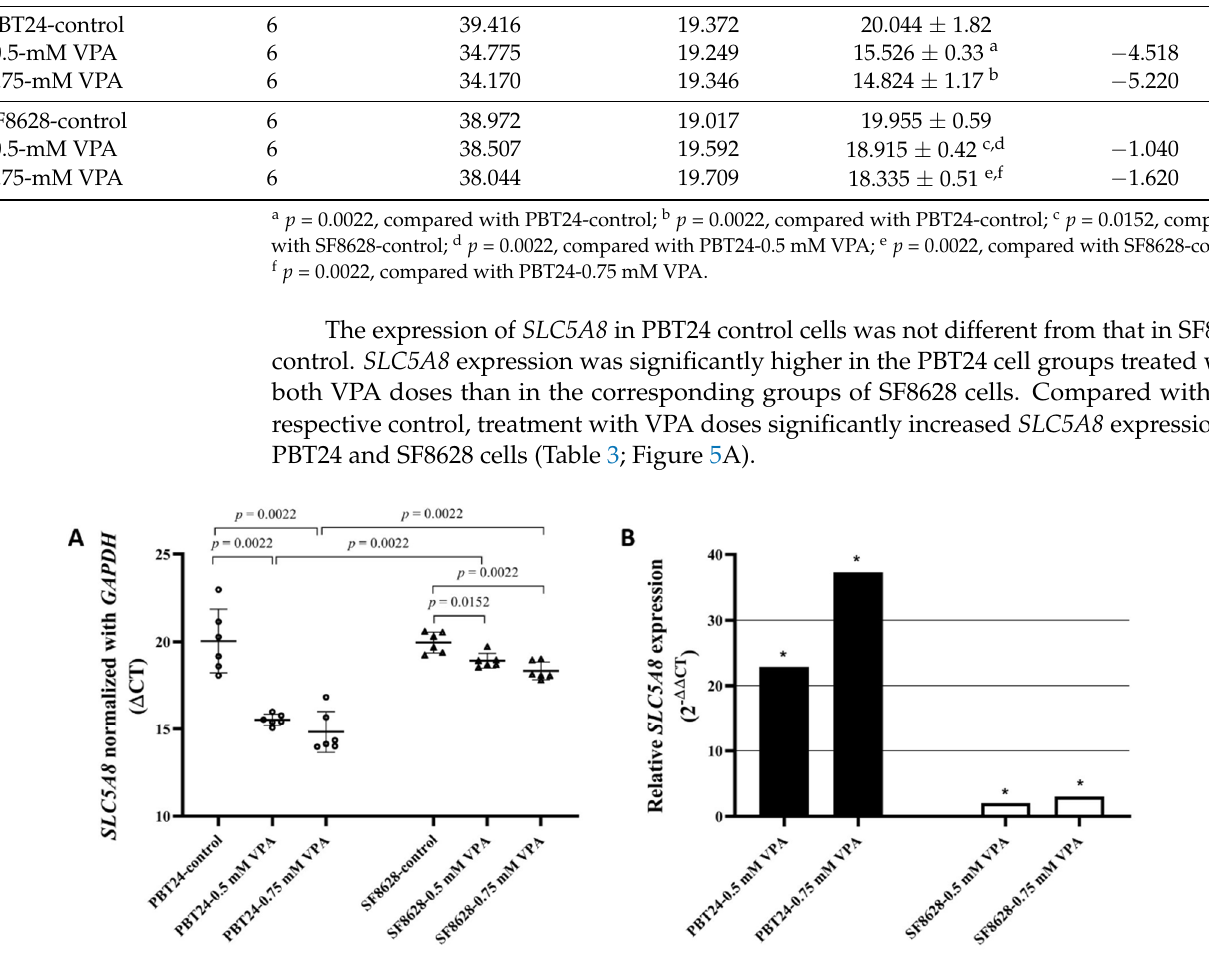
Figure 5. ( A ) SLC5A8 expression in PBT24 and SF8628 control groups and VPA-treated groups. Data are after normalization with GAPDH . Delta threshold cycle ( ∆ CT) values were used for the graph (the horizontal bars represent the mean; the short horizontal lines show SD values). ( B ) SLC5A8 relative expression in PBT24 and SF8628 VPA-treated groups compared with respective control. The 1.0 line shows the starting point of gene expression; * p < 0.05.